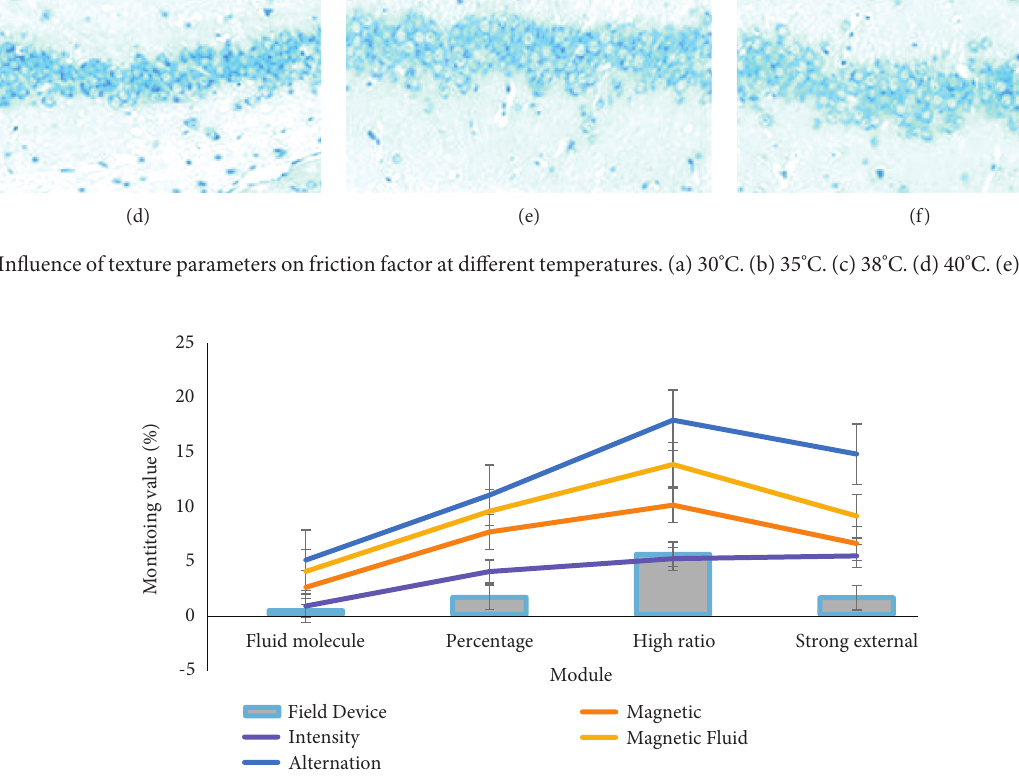
Figure 2: Distribution of the magnetic field generated by the Helmholtz coil.